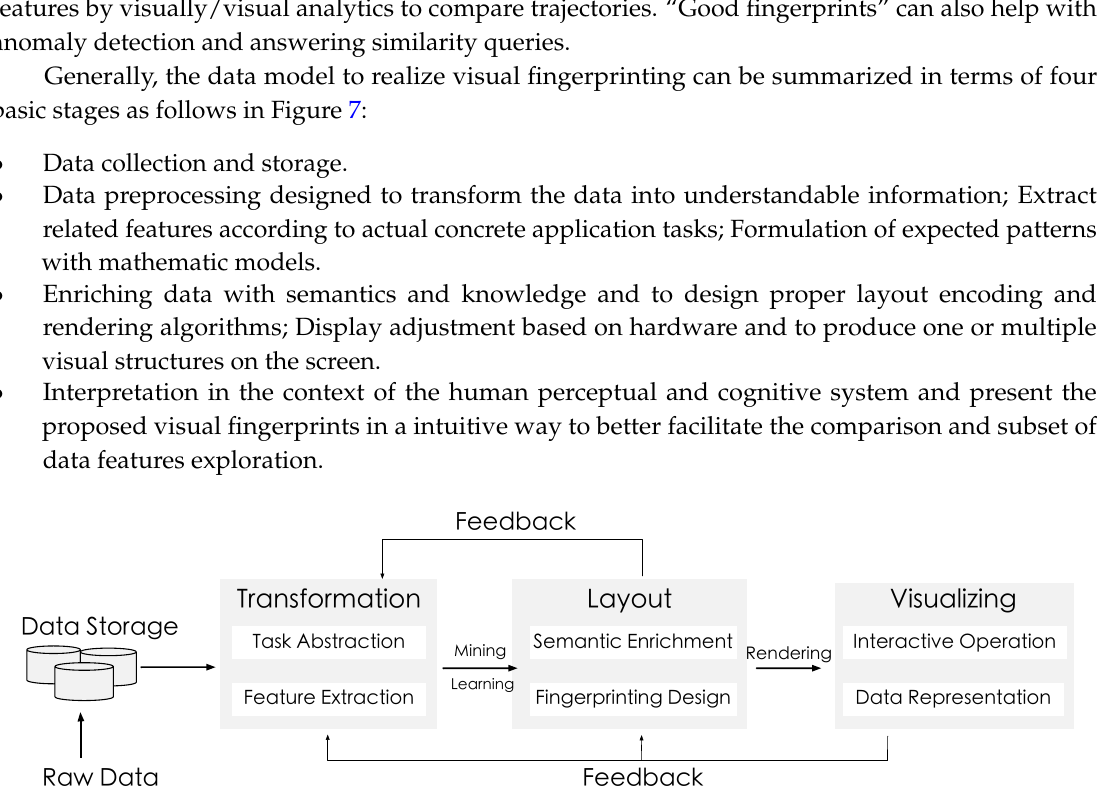
Figure 7. Data model for visual